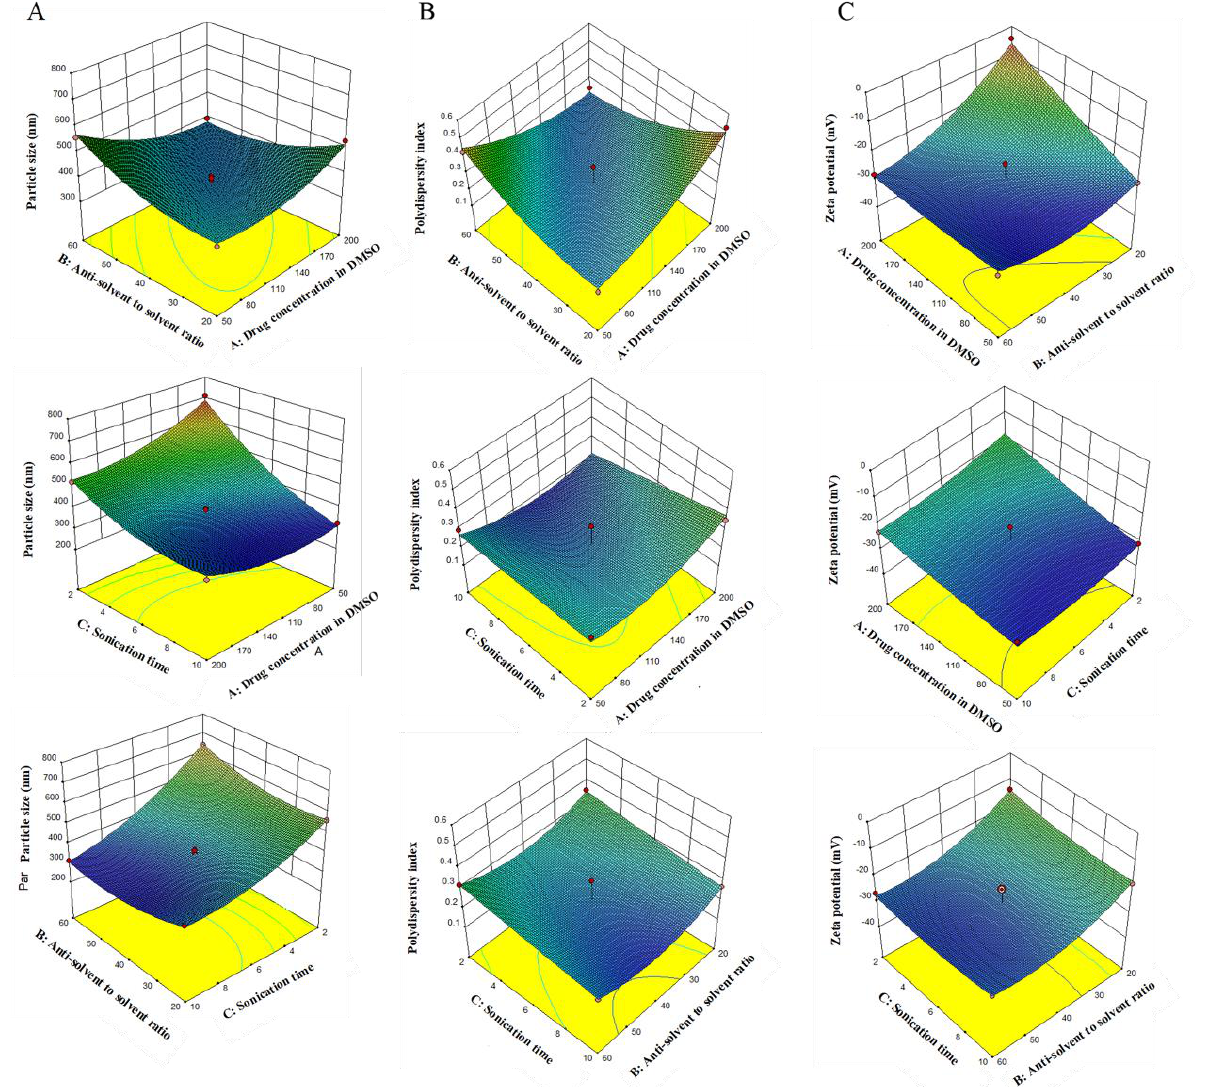
Figure 1. Effect of drug concentration in DMSO, anti-solvent to solvent ratio and sonication time on particle size ( A ), PDI ( B ), and zeta potential ( C ).